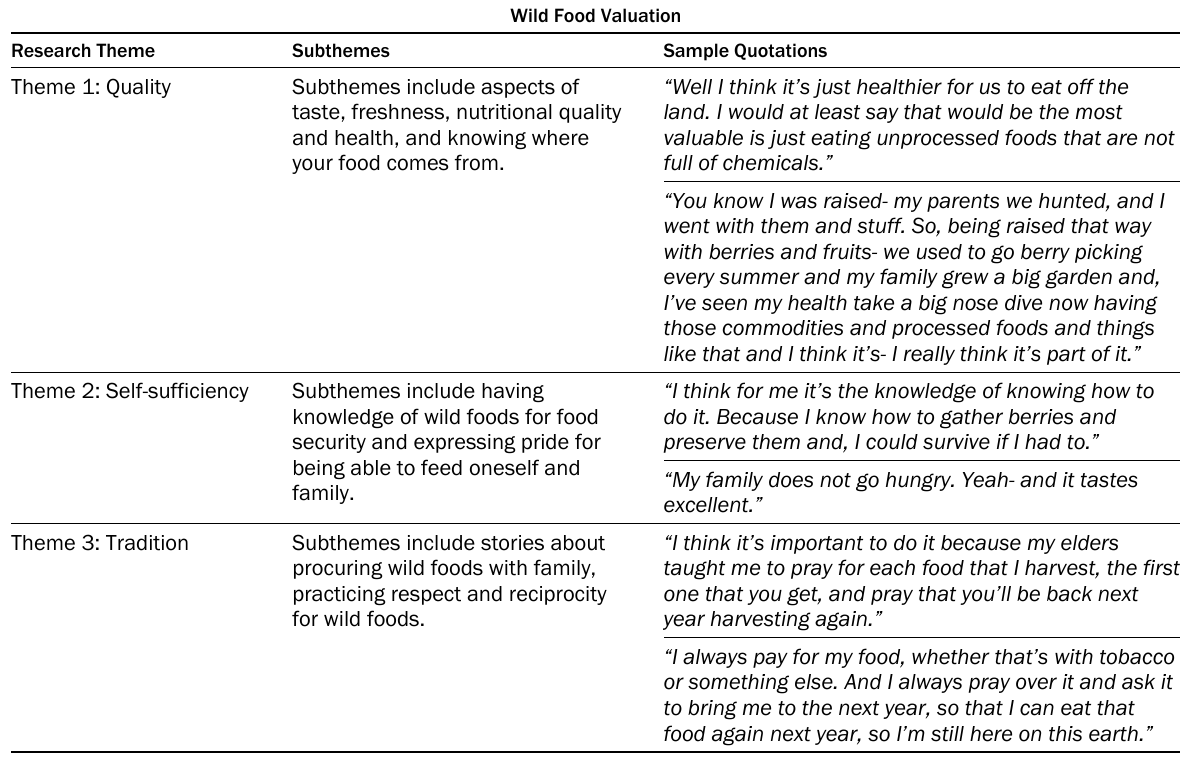
Table 2. Summary of Wild Food Valuation Themes, Subthemes, and Sample Quotations from Participants Wild Food